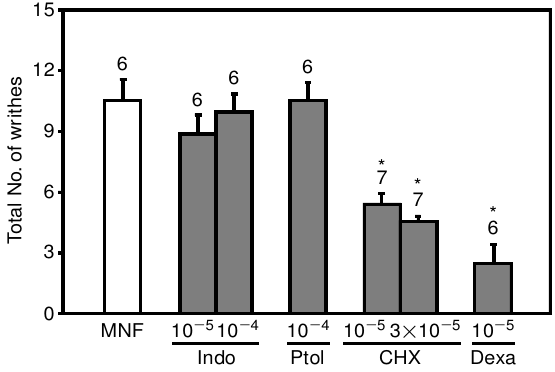
FIG. 2. Effects of indomethacin, paracetamol, cycloheximide and dexamethasone on MNF release. The bars show the number of writhes induced by the supernatant (0 · 1 ml / g body weight, i.p.) from LPS-pretreated macrophages in the absence (MNF) or the presence of the indicated concentra- tion (M) of indomethacin (Indo), paracetamol (Ptol), cyclo- heximide (CHX) or dexamethasone (Dexa). The number at the top of each bar represents the number of mice in that group. The values are reported as means SEM of the total number of writhes occurring between 14 and 34 min after MNF injection. , Statistically signi® cant differences (P , 0 · 05) from the control group determined by ANOVA and Bonferroni’s